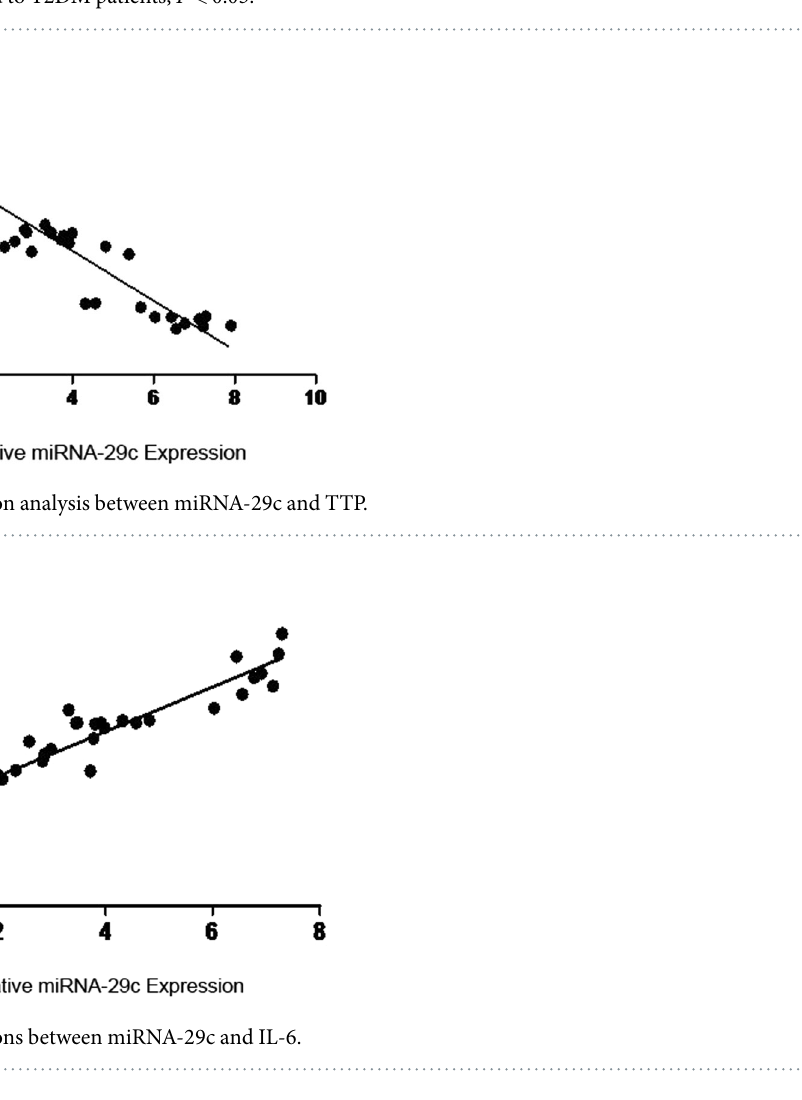
Table 2. The Levels of IL-6, TNF- α and TTP in Plasma and Urine Samples. * Compared to control subjects, P < 0.05. # Compared to T2DM patients, P < 0.05.